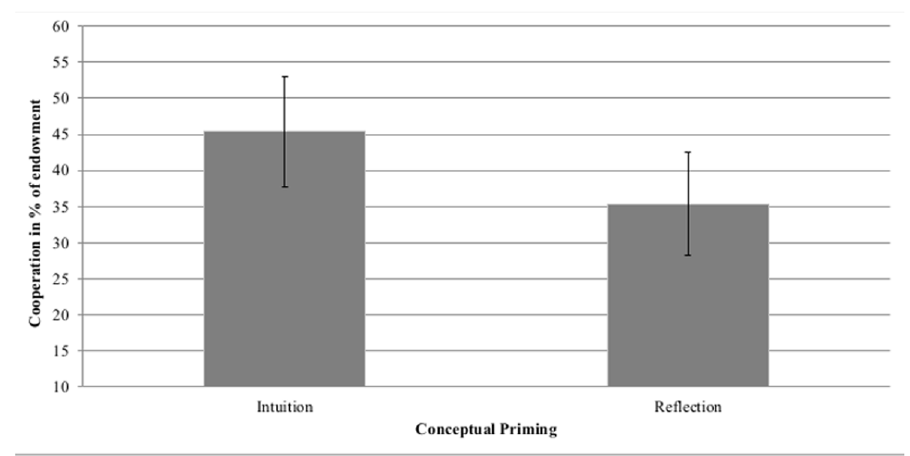
Fig 1. Mean Rates of Cooperation. Cooperation is displayed by conceptual priming (Intuition: intuition good/ reflection bad vs. Reflection: intuition bad/ reflection good). Error bars represent 95%-level confidence intervals. Intuition refers to primes that promote intuition or inhibit reflection (intuition good, reflection bad), reflection refers to primes that promote reflection or inhibit intuition (reflection good, intuition-bad). Based on n = 246 observations.